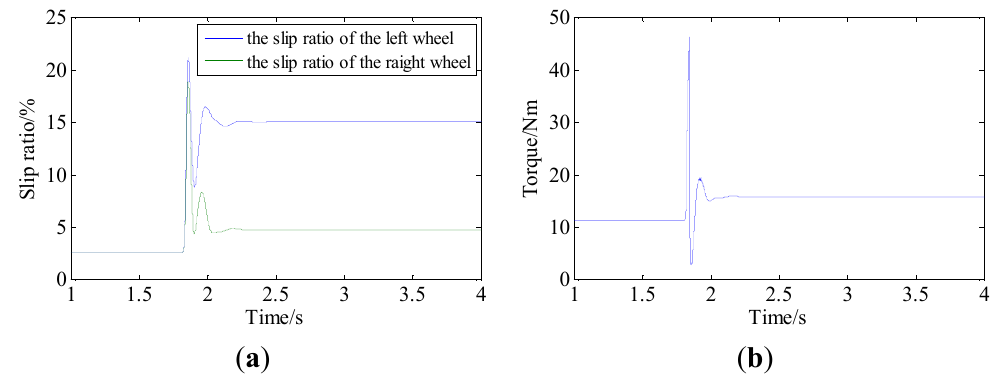
Figure 6. Typical slip ratio control progress without yaw rate compensation: ( a ) slip ratios of both wheels and ( b ) torque